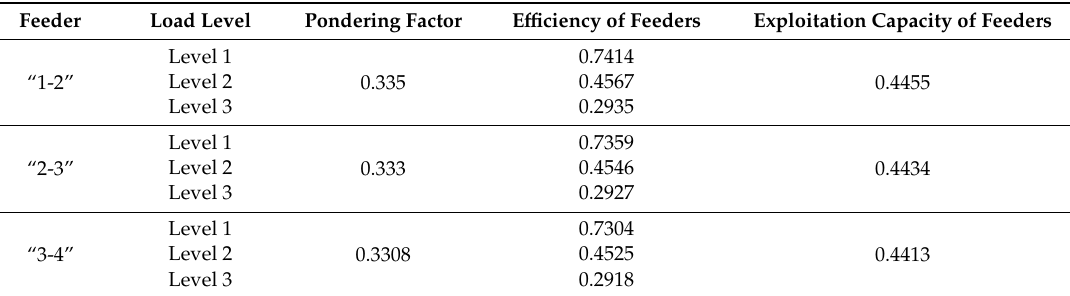
Table 3. Results of the validation process, case 2.